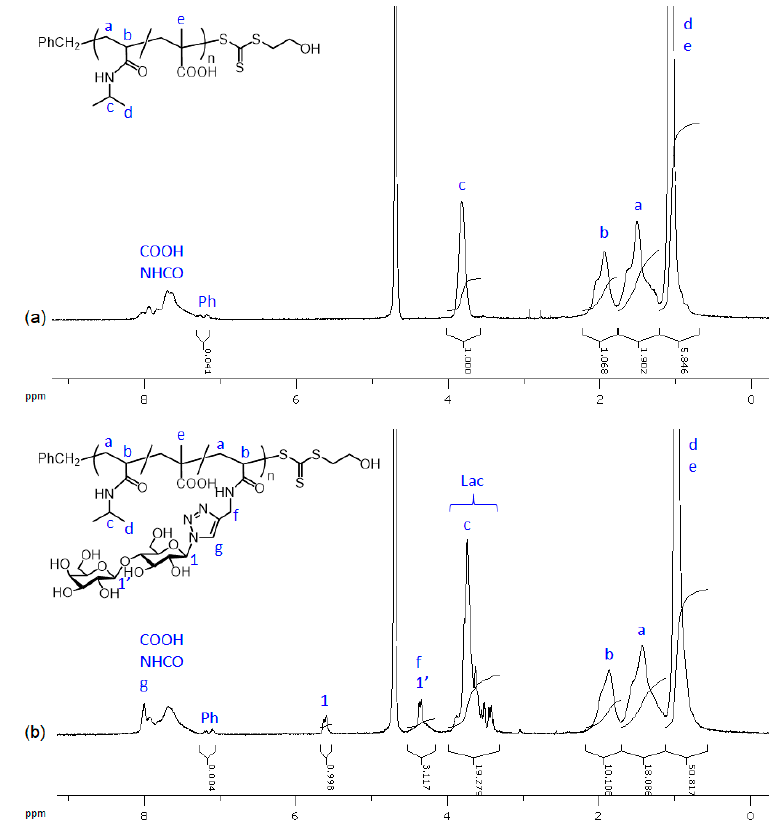
Figure 2. 1 H NMR spectra of ( a ) P1 and ( b ) P4 in D 2 O.